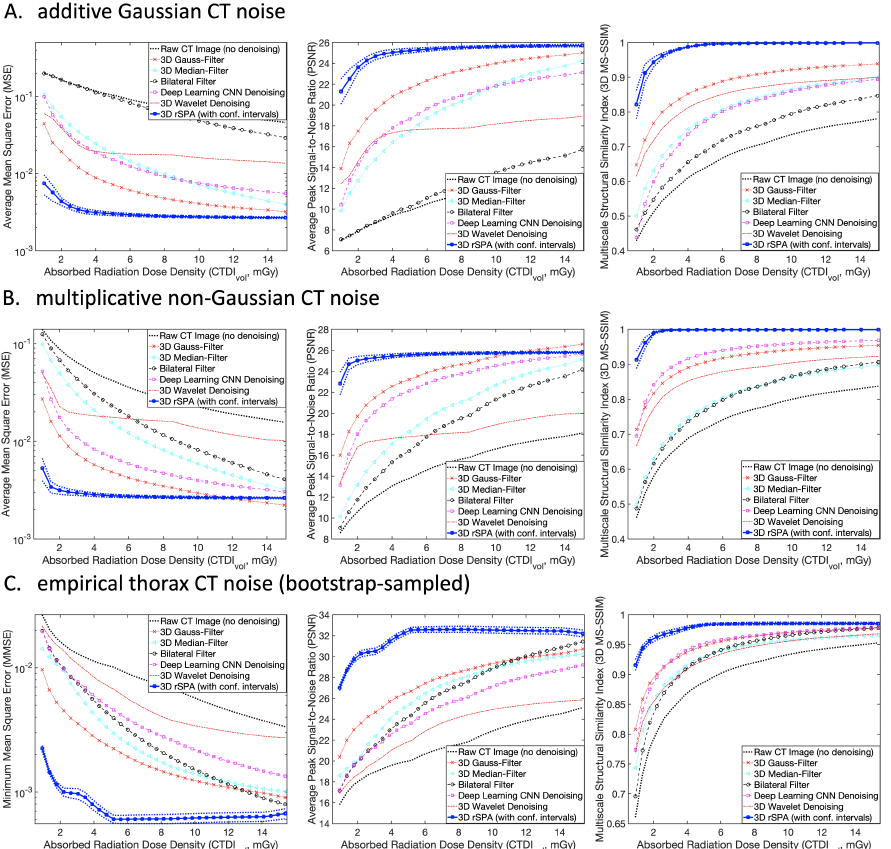
Figure 6. Comparing CT image denoising performances for three CT noise models: ( A ) additive Gaussian noise model (CT noise variance is independent of the feature color); ( B ) multiplicative non-Gaussian noise model (CT noise variance changes with the amplitude of the underlying color signal); ( C ) empirical noise obtained from the thorax CT patient data. In ( A , B ), generation of synthetic images was performed for a patient with a water-equivalent diameter of 30 cm, which is subject to a Thorax CT with a typical tube voltage of 120 kV in the range of tube currents between 5–180 mA and a set of artificial anatomic features from Figure 2A (with a feature contrast of 200 HU). In ( C ), real patient data were used. Comparison is performed with three primary image quality criteria: with mean squared error (left panels); with peak signal-to-noise ratio (middle panels); and with the 3D multiscale structural similarity index (right